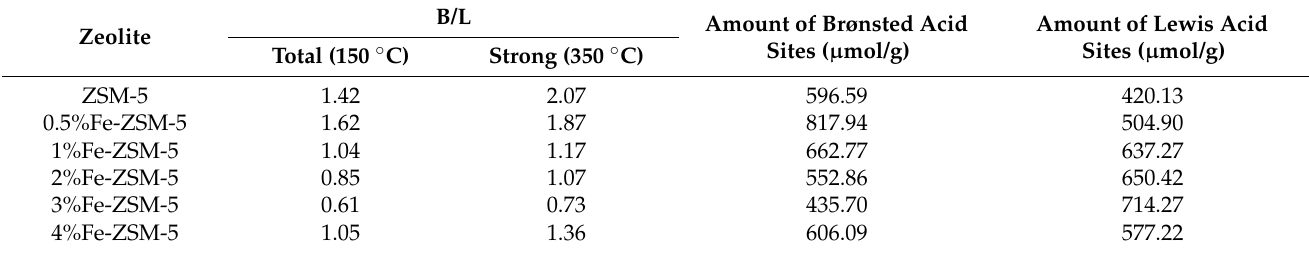
Table 3. The amount of Brønsted and Lewis acid sites of